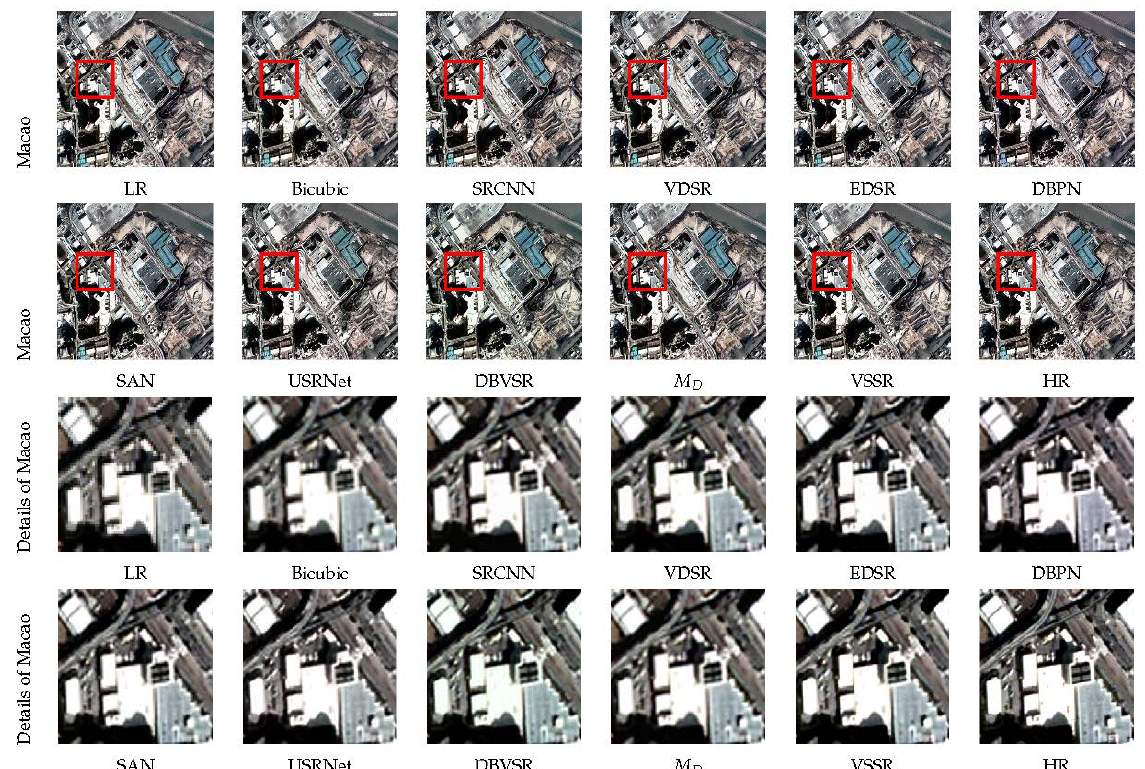
Figure 9. Reconstruction results on the third frame of Macao (Jilin-1 data) by the scale factor of ×